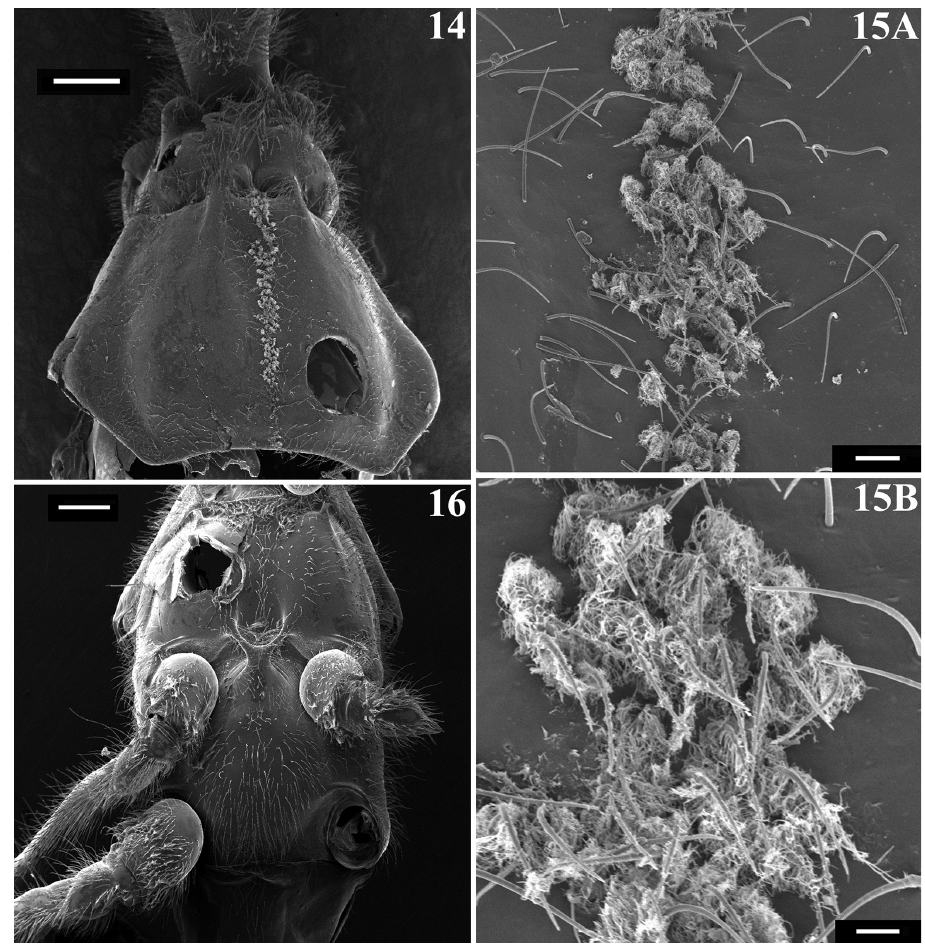
Figures 14–16. Parahiranetis salgadoi Gil-Santana, male thorax. 14 pronotum, dorsal view 15 setae of the midlongitudinal line of the pronotum with flocky patches of wax-like substance A–B under pro- gressively higher magnification 16 meso- and metathorax, ventral view. Scale bars: : 0.5 mm ( 14, 16 ); 0.05 mm ( 15A ); 0.02 mm ( 15B